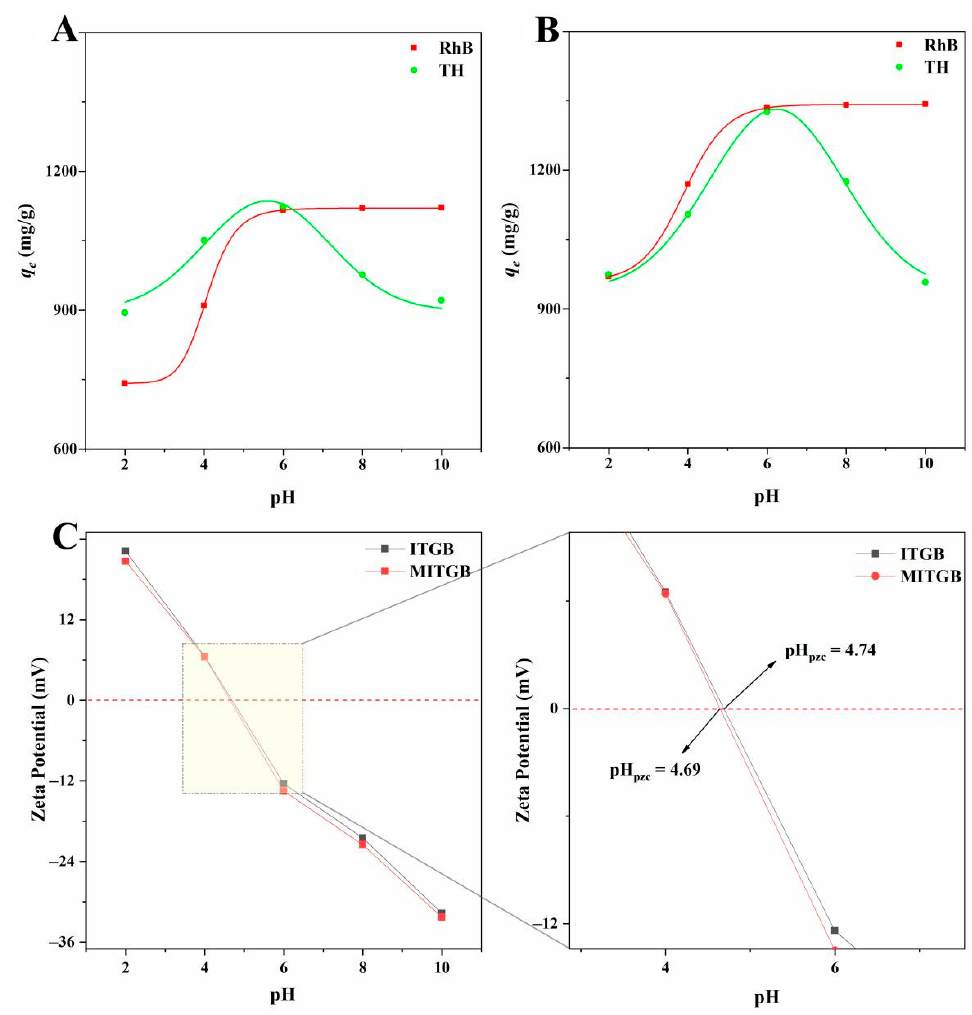
Figure 8. Effect of pH on the adsorption capacities of ( A ) ITGB and ( B ) MITGB. ( C ) Zeta potential of ITGB and MITGB.